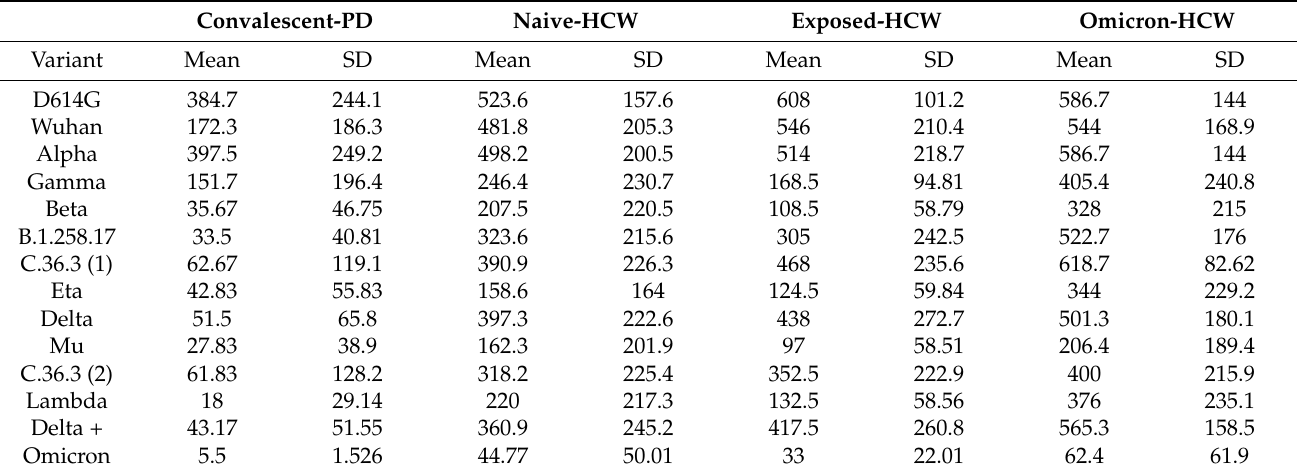
Table 3. Neutralizing titers of the different population of the study against the 14 SARS-CoV-2 variants tested. The results are expressed as means and standard